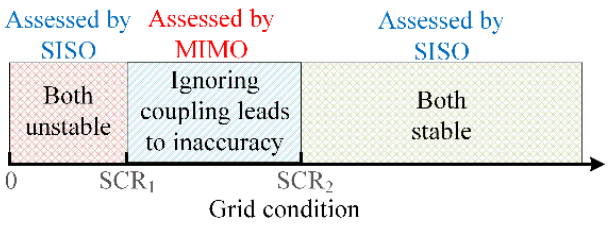
Figure 20. Method of the stability assessment of the grid-connected MMC system.